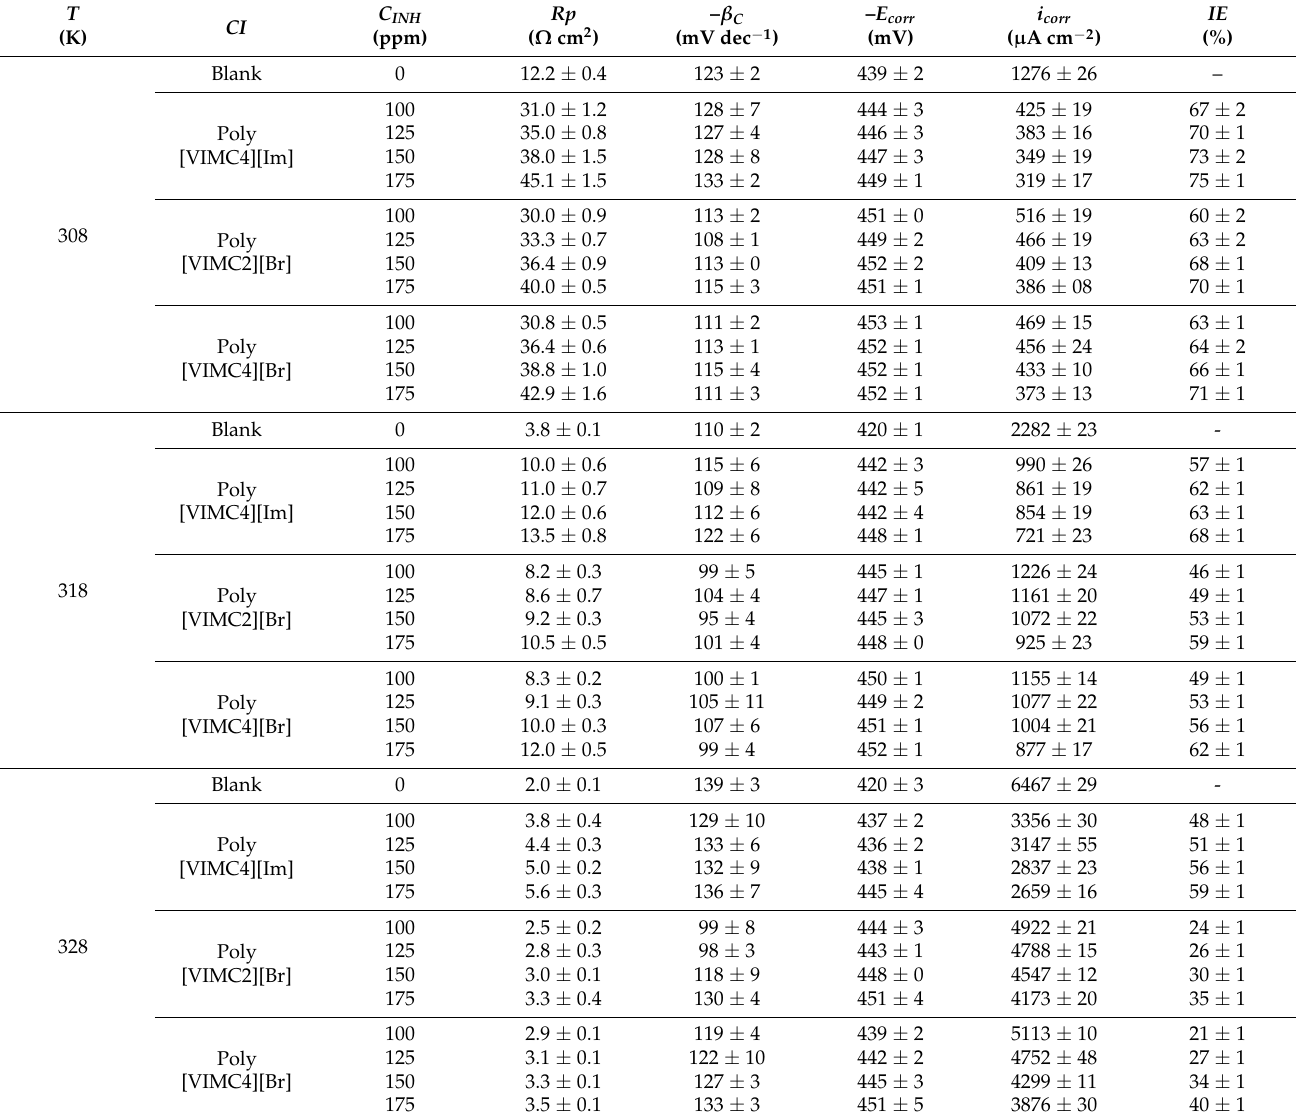
Table 3. Electrochemical parameters of API 5L X60 steel in 1 M H 2 SO 4 —CIs at different temperatures by the LPR and PDP